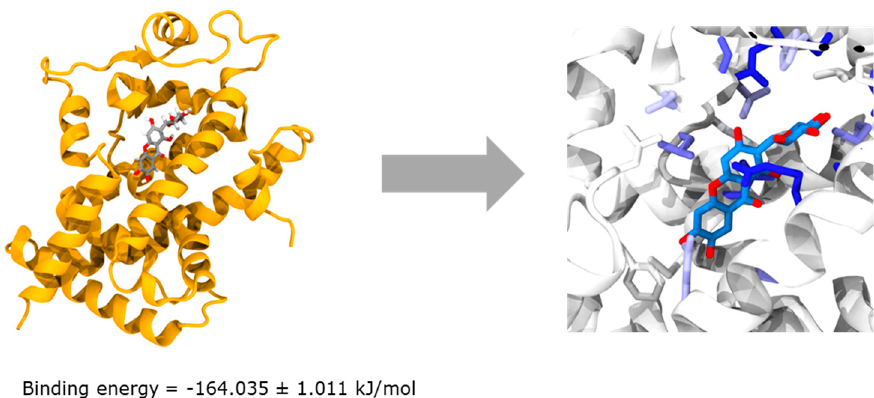
Figure 2. Representation of the binding energy relative to the interaction between mangiferin and PPAR γ ( left ) with the identification of engaged residues in the interaction ( right ).